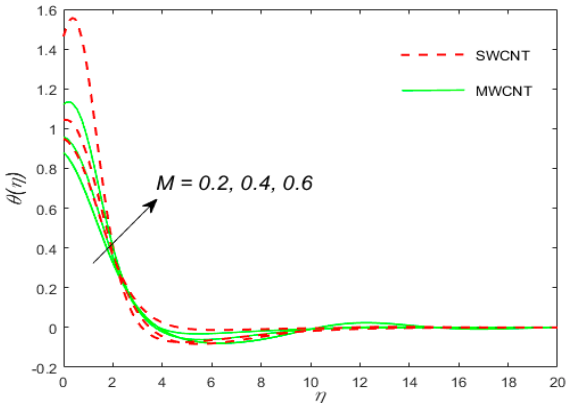
Figure 10. The impact of the temperature distribution profile θ ( η ) for the case of SWCNT and MWCNT versus the similarity variable for the distinct values of the Eckert number Ec .